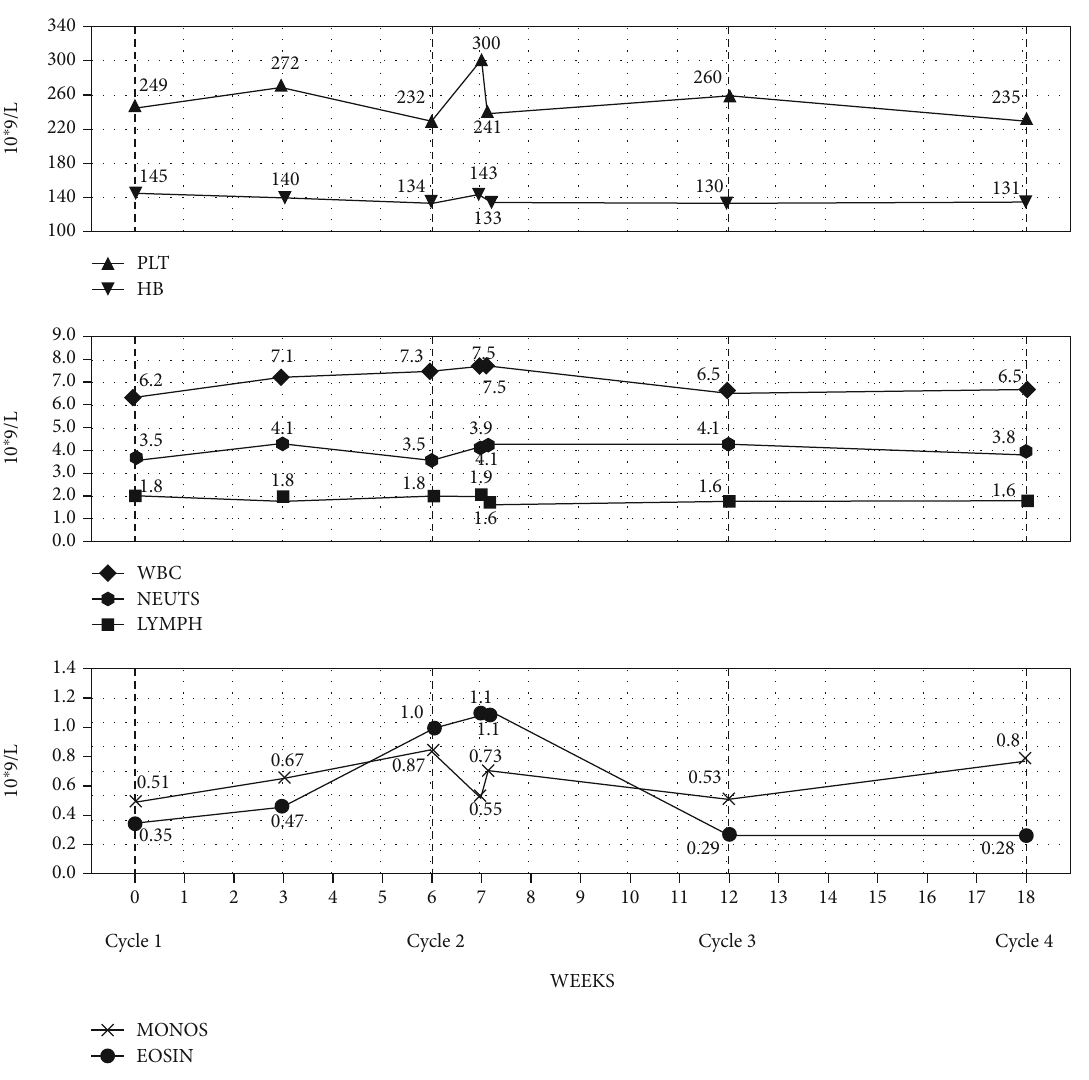
Figure 1: Line graphs depicting serial full blood count values over time over cycles 1-4. Eosinophils were the only subset of cells that elevated above normal range after cycle 1 before returning to normal at time of cycle 3. Normal ranges for haemoglobin (130-162), white cell count (4.3-11.2), platelets (150-400), neutrophils (1.90-7.90), basophils (0.05-0.10), monocytes (0.30-0.90), eosinophils (0.03-0.44), and lymphocytes